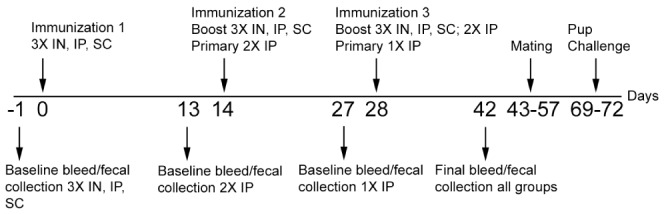
Timeline of immunization and challenge experiments.Immunizations and baseline bleeds/fecal collections were staggered depending on the number of immunizations per group to allow for the final/only immunization(s) to occur on the same day for all groups. All boosts occurred at 14-day intervals, and a final bleed/fecal collection occurred 14 days following the final/initial immunization.